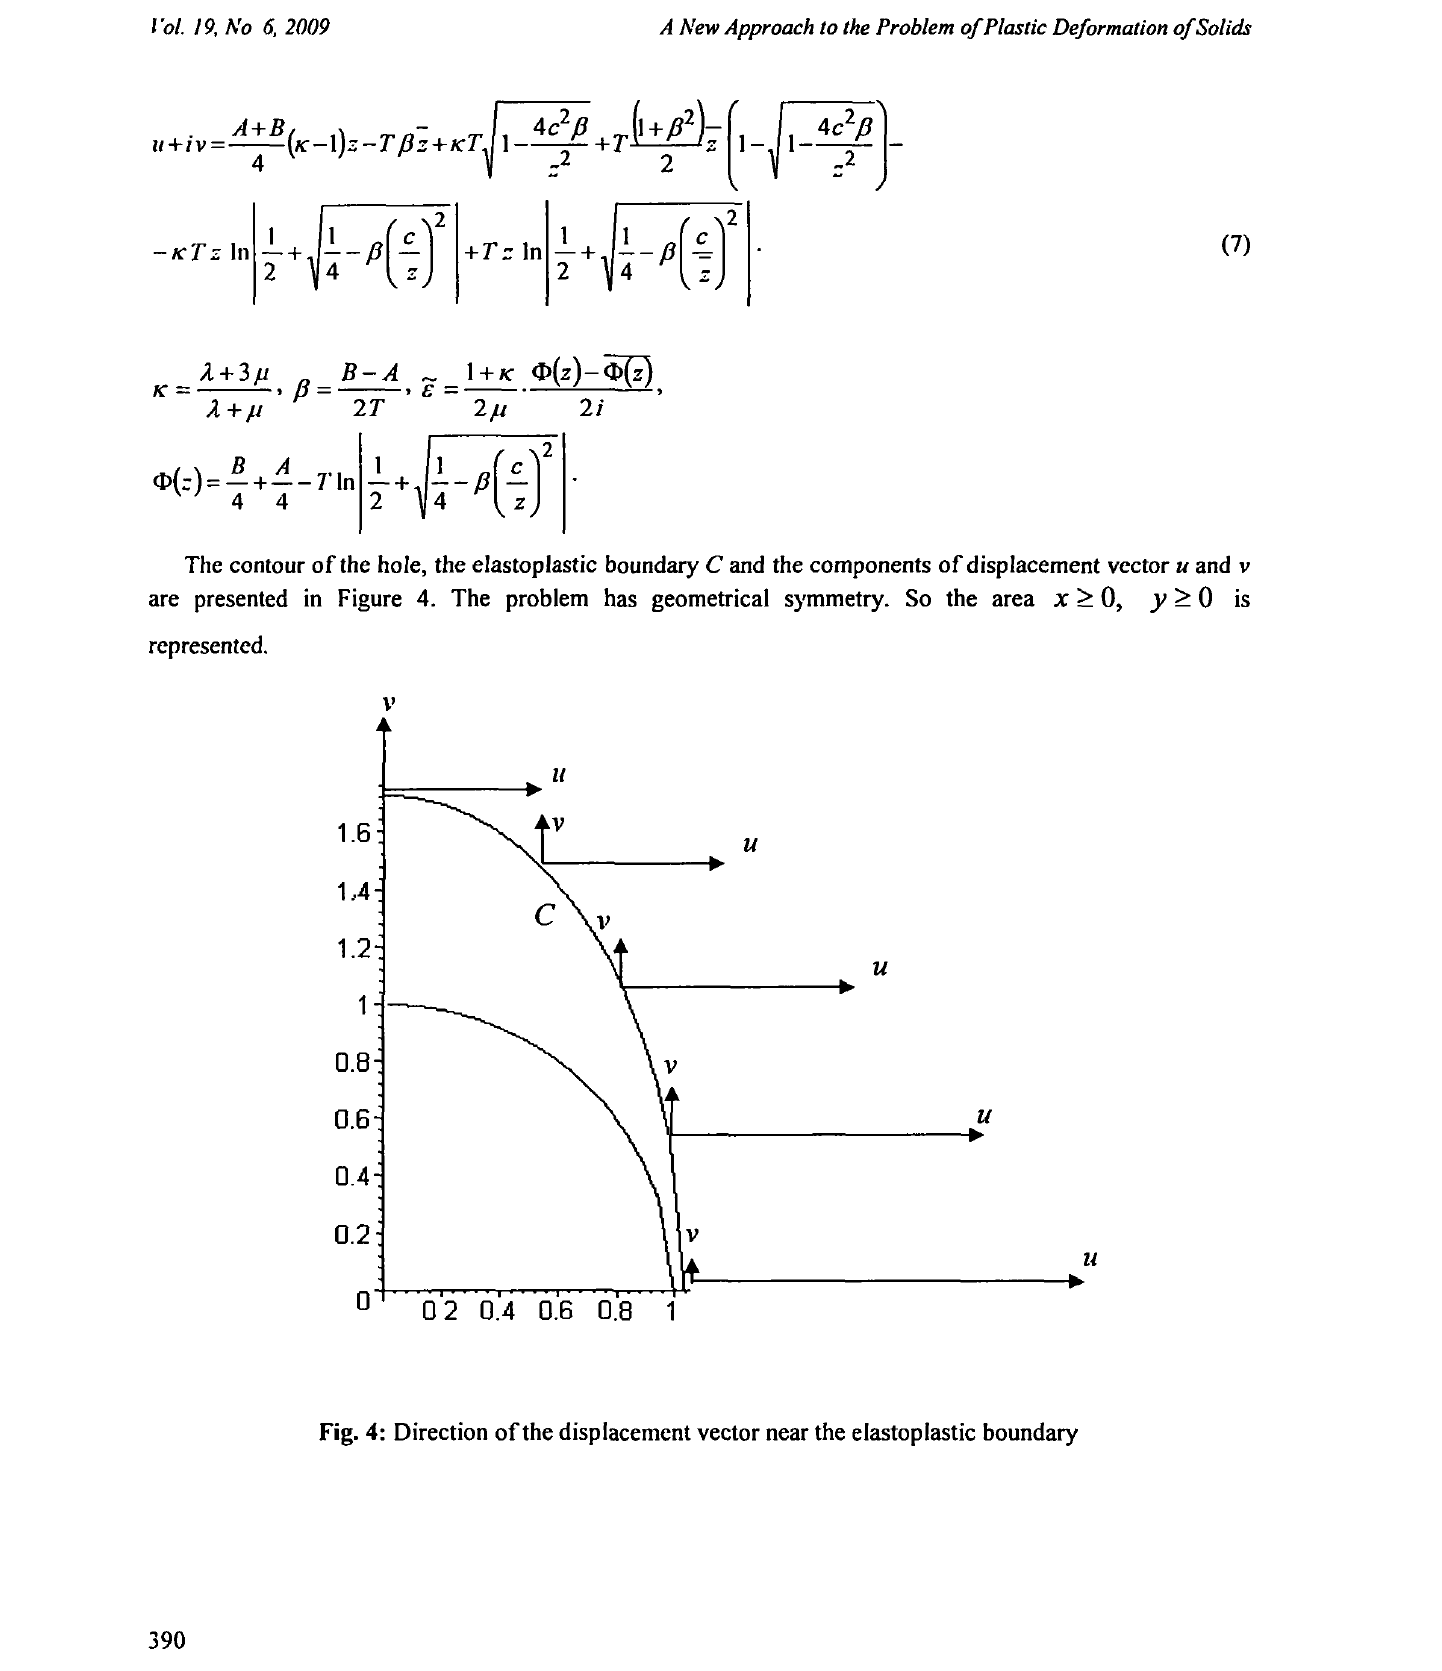
Fig. 4: Direction of the displacement vector near the elastoplastic